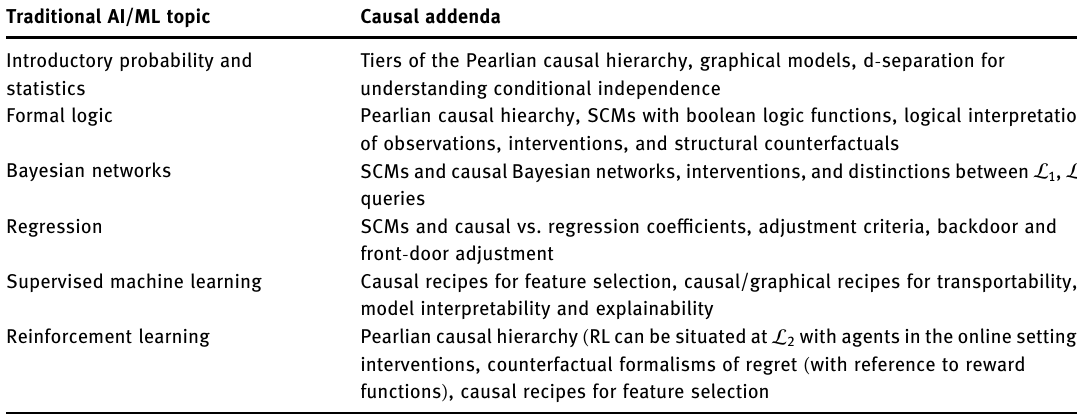
Table A3: Ad hoc causal addendum possible for gradual integration of topics into traditional curricula Traditional AI/ML